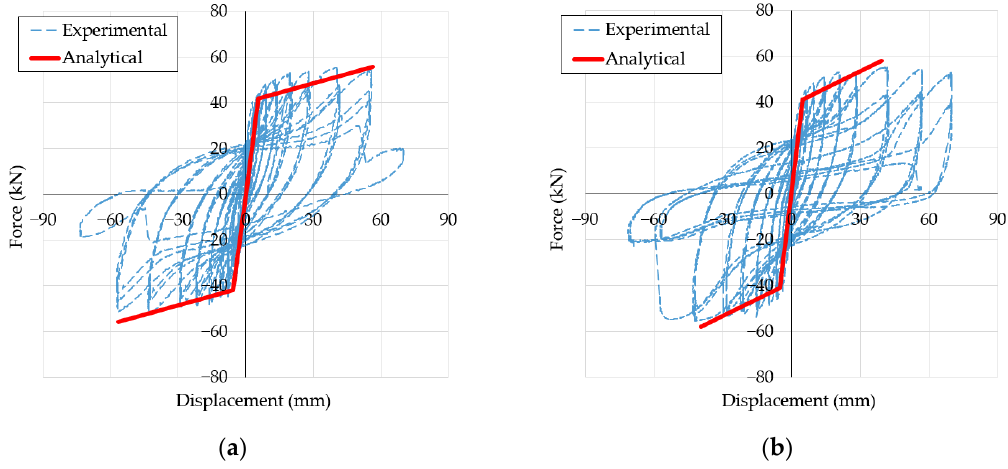
Figure 12. Plastic hinge analysis results for wall units SW1 and SW4 [14]. ( a ) SW1. ( b ) SW4.